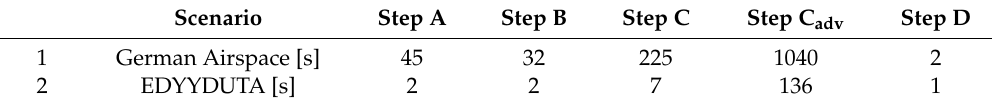
Table 2. Computation times in seconds for the process steps A to D (Sections 3.3.1 and